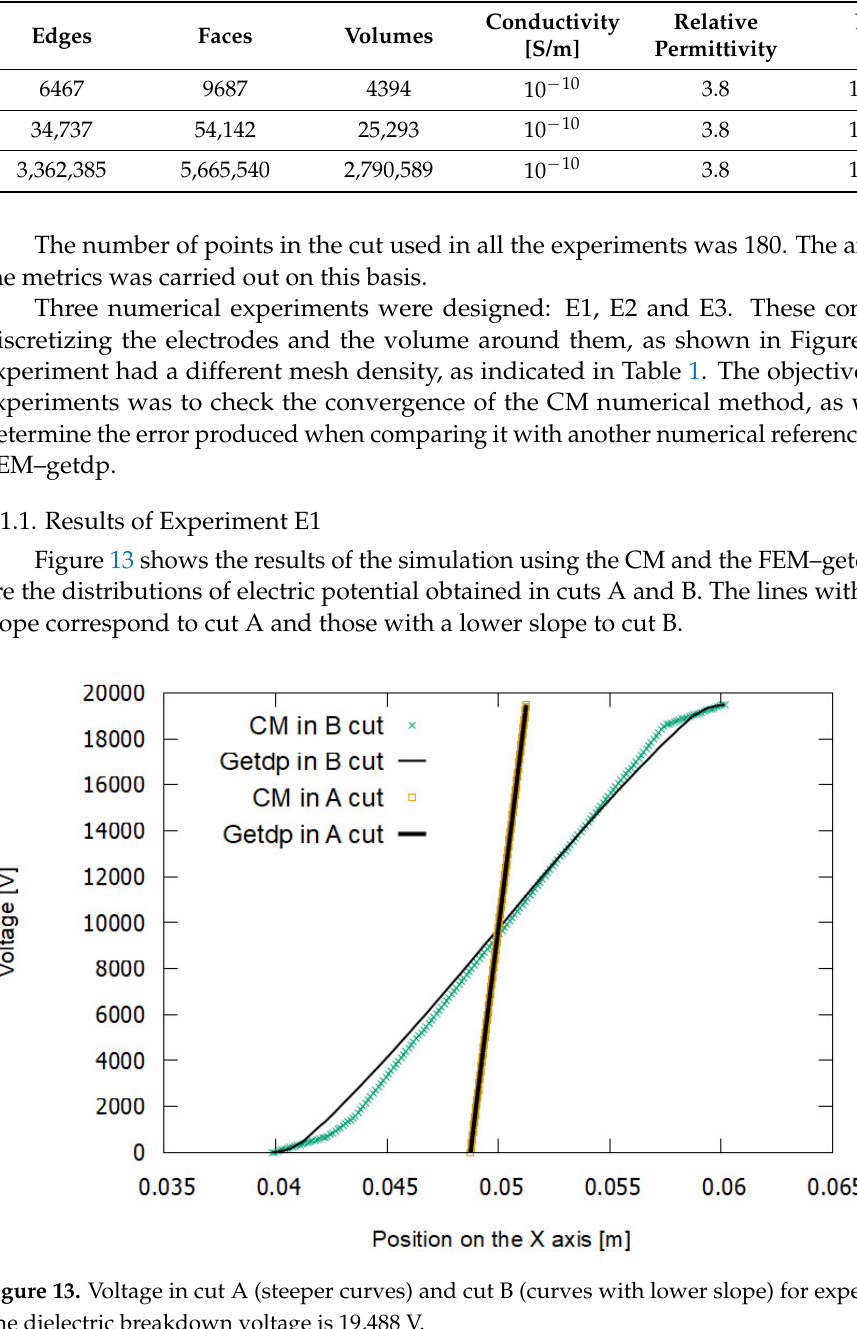
Figure 14. Electric field in cut A (upper curves) and cut B (lower curves) for experiment E1. In experiment E1, a low-density mesh was used. In Figure 13, it can be seen that the voltage values in the FEM–getdp and CM are almost coincident for cut A. However, they differ more for cut B. In Figure 14 there is a notable difference between the values of the electric field given by the FEM–getdp and those given by the CM, in both cut A and cut B, because the mesh is not very dense.